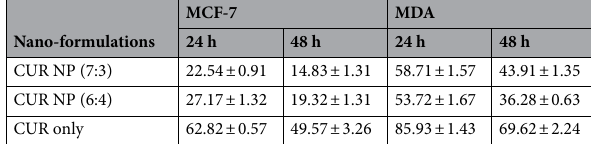
Table 2. Depicts the IC 50 values of CUR NPs and CUR alone treated on MCF-7 and MDA-MB-231 cell lines.